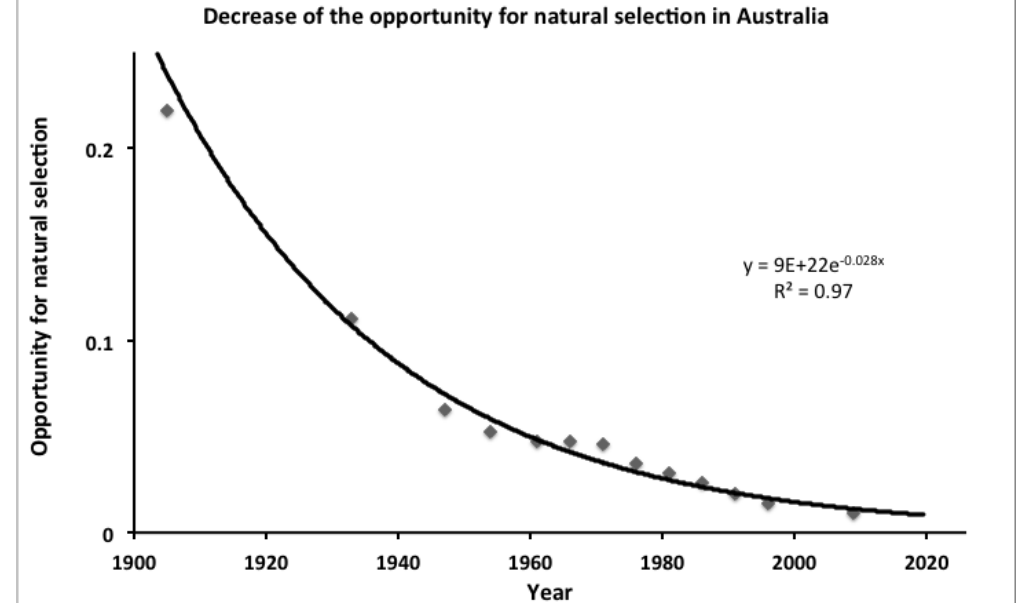
Figure 2. Decline of the opportunity for natural selection in Australia during the last 100 years. The opportunity is measured as a ratio of individuals unable to pass on their genes to the next generation to those able to participate in reproduction of new generations. Based on data from [23] and supplemented by new information